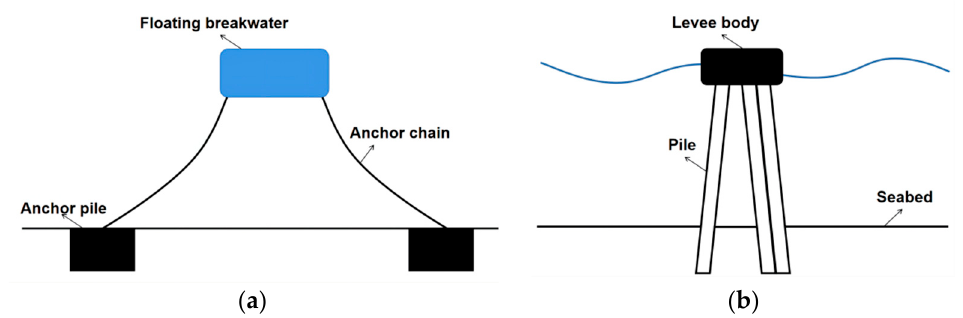
Figure 2. Floating breakwater ( a ) and pile-permeable breakwater ( b ).